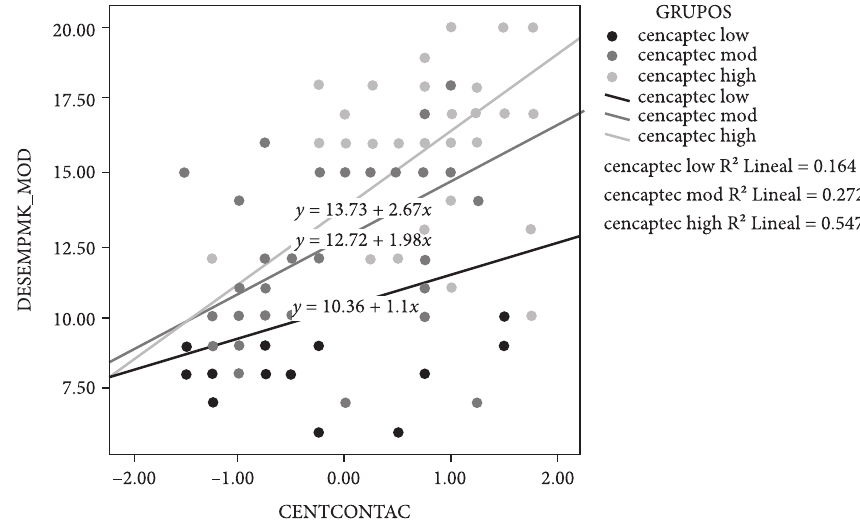
Figure 2. Graph of regression effects between tacit knowledge and firm performance depending on different levels of technical capabilities